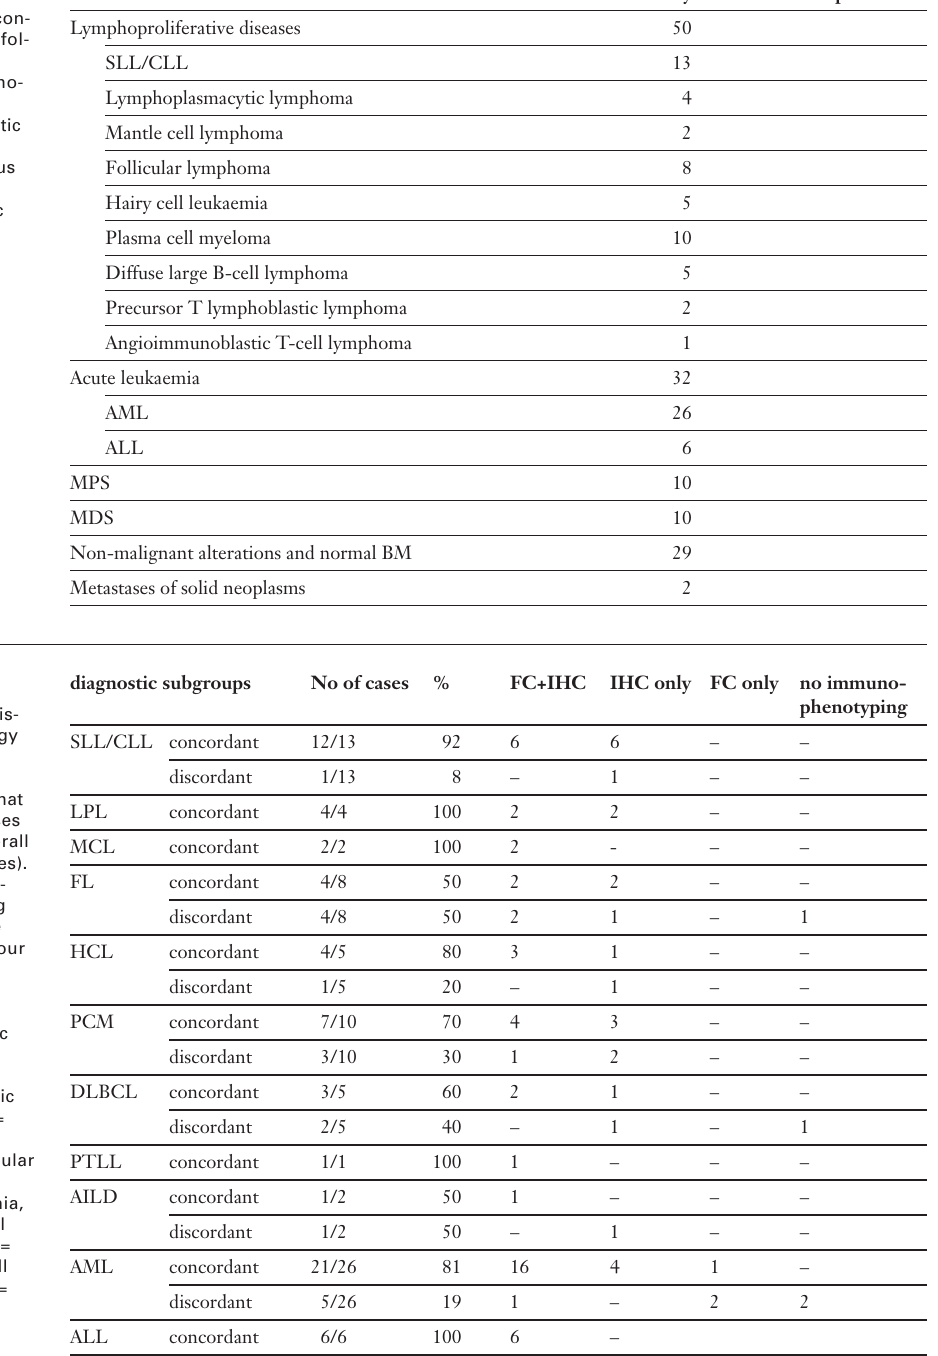
Diagnoses of 133 studied cases as con- firmed by clinical fol- low-up (SLL/ CLL = small lympho- cytic lymphoma/ chronic lymphocytic leukaemia, AML = acute myelogenous leukaemia, ALL = acute lymphocytic leukaemia).